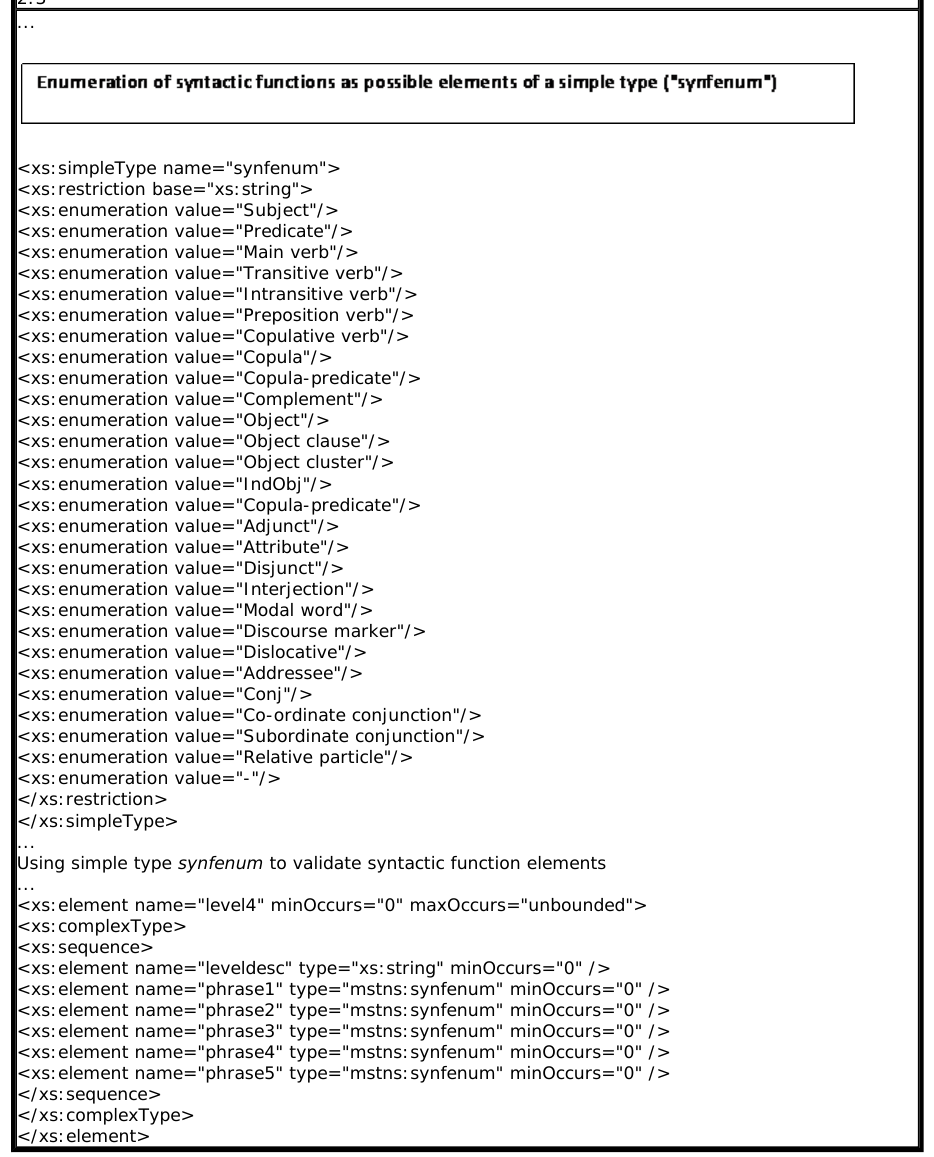
Table 2 Taxonomy of syntactic functions in Biblical Hebrew (Kroeze 2000a, 2000b, 2002,